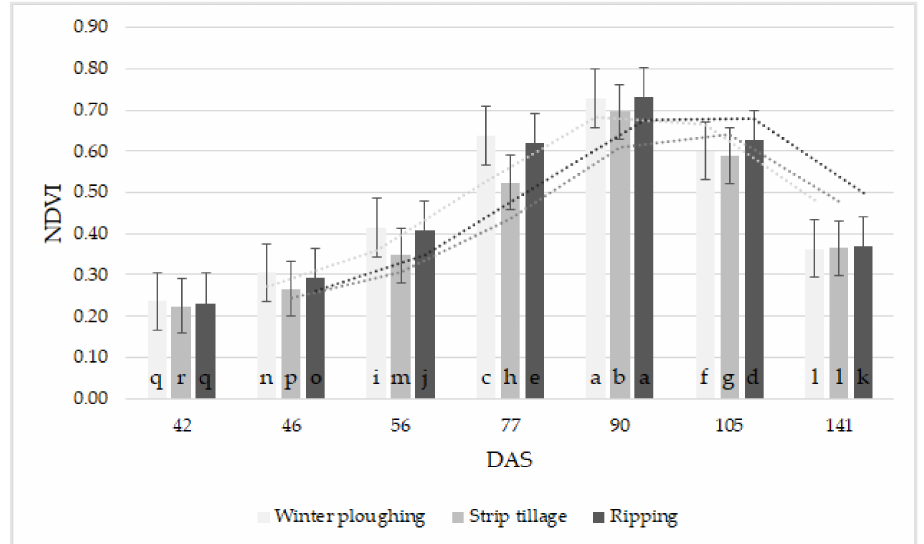
Figure 8. The NDVI UAV values of maize as the effect of tillage at different DAS (Debrecen, 2021); means of the varieties ± standard error. At the p = 0.001 level, the differences between the DAS treat- ments were considered significant. The different letters indicate treatments that differ significantly ( p < 0.05). LSD = 0.005.